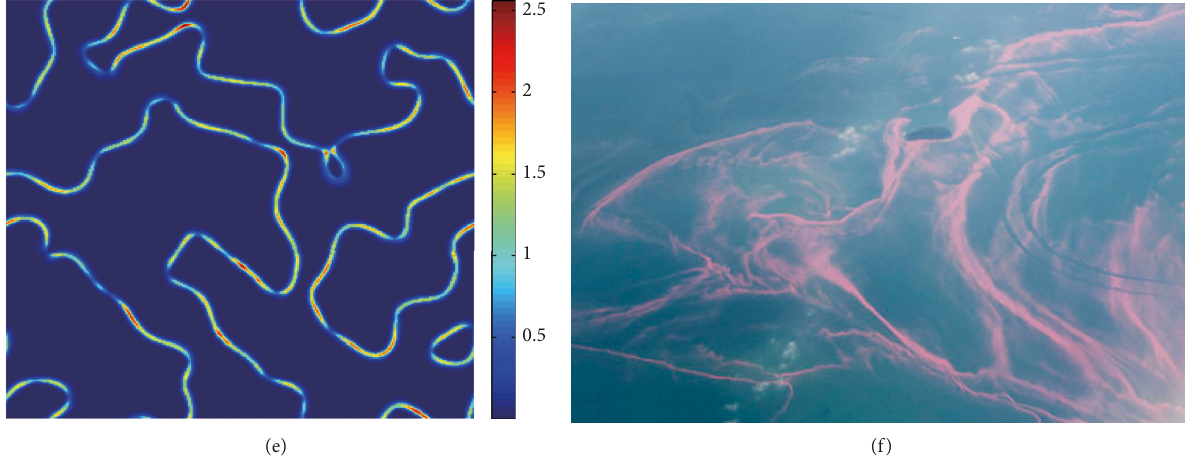
Figure 11: Banded patterns. Parameter values: (a) I � 1 . 6, a � 0 . 5, b � 0 . 8, α � 0 . 7, e � 0 . 2, m � 0 . 45, d h � 1, ε � 0 . 001, t � 100, and n � 100. (b) On November 25, 2014, the phytoplankton bloom photographed in the sea near Shenzhen, China; (c) I � 1 . 6, a � 0 . 5, b � 0 . 8, α � 0 . 7, e � 0 . 2, m � 0 . 45, d